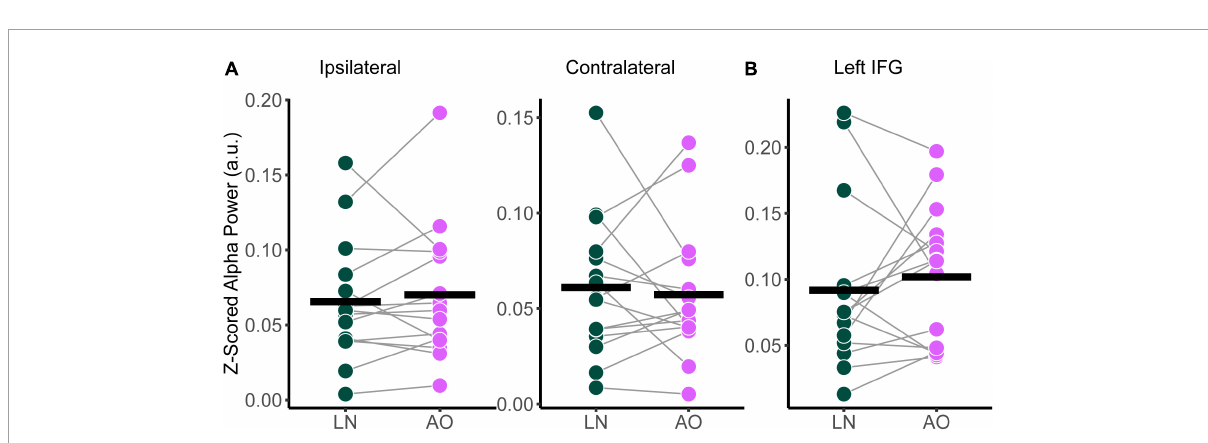
FIGURE6 Comparison of relative alpha power between audiovisual Low-Noise (LN) and the Audio-Only (AO) conditions (bottom row) for the (A) ipsilateral and contralateral superior-parietal region and (B) left inferior-frontal gyrus (IFG) ROIs. No statistically significant differences were detected.